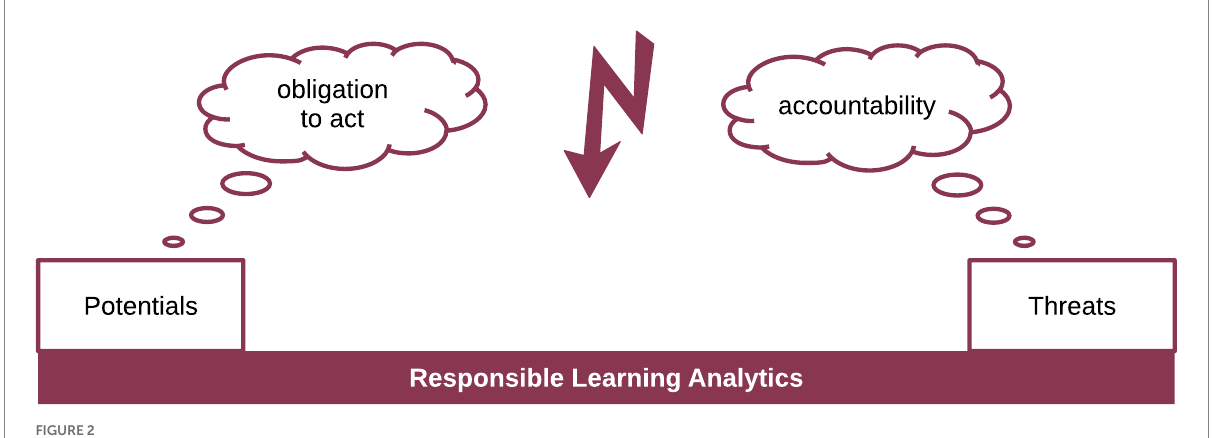
FIGURE 2 Responsible learning